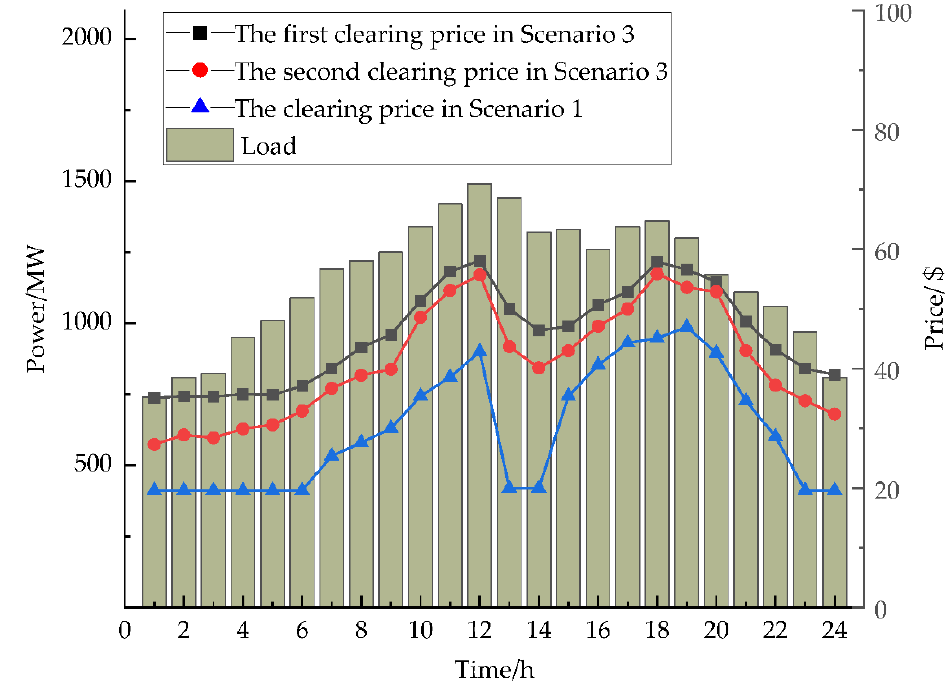
Figure 7. Comparison of market clearing electricity prices in three scenarios.